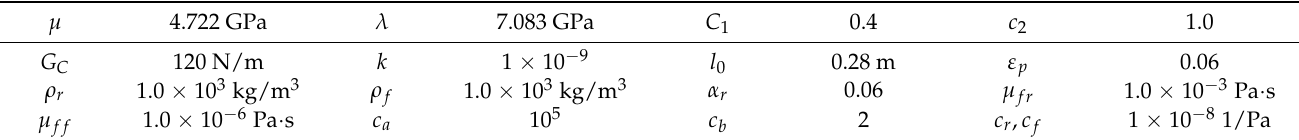
Table 1. The input parameters for